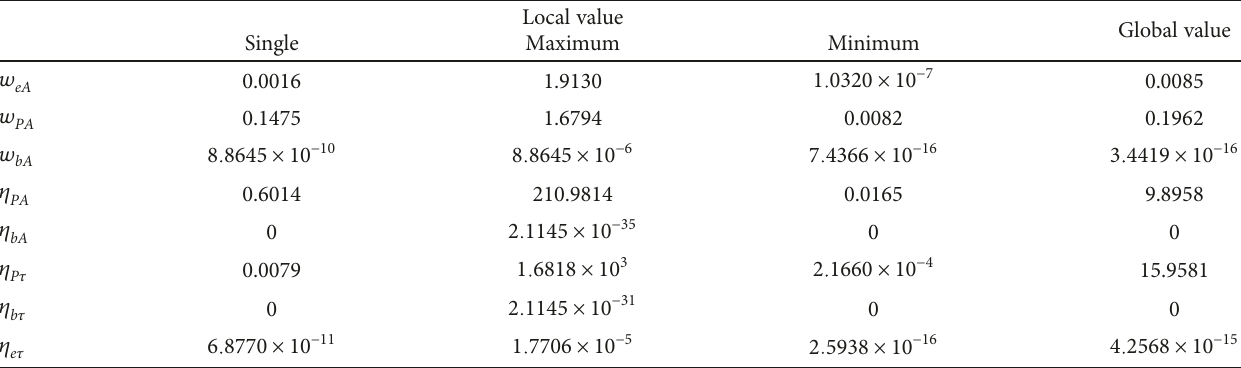
Table 4: Kinematic and dynamic coupling indexes with the fourth and seventh joints locked.